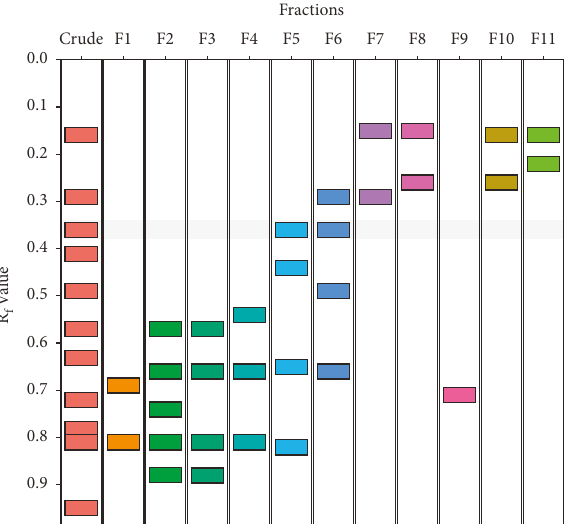
Figure 4: Retardation factors ( R f ) from thin-layer chromatography (TLC) of crude EtOAc extracts and fractions of the crude extract obtained using column chromatography.